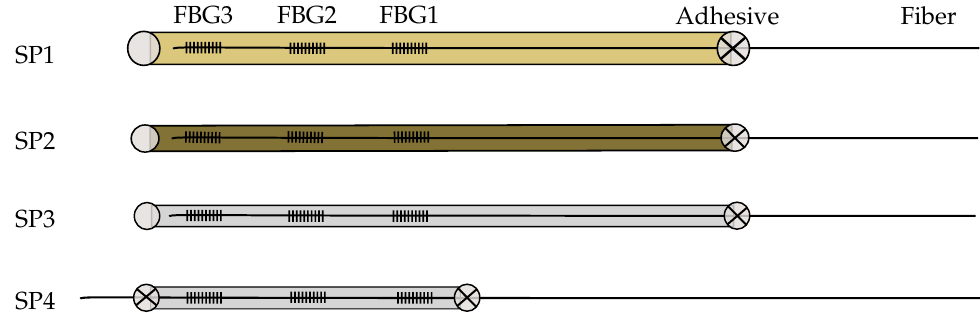
Figure 1. The investigated sensor samples (SP); SP1: optical fiber in PEEK capillary, single-point mounting; SP2: optical fiber in fused silica tube with polyimide coating, single-point mounting; SP3: optical fiber in fused silica tube, removed polyimide coating, single-point mounting; SP4: optical fiber in fused silica tube, removed polyimide coating, double-point mounting; vertical lines indicate the FBGs; grey circles indicate adhesive points; grey circles with an X indicate a connection between encapsulation and the